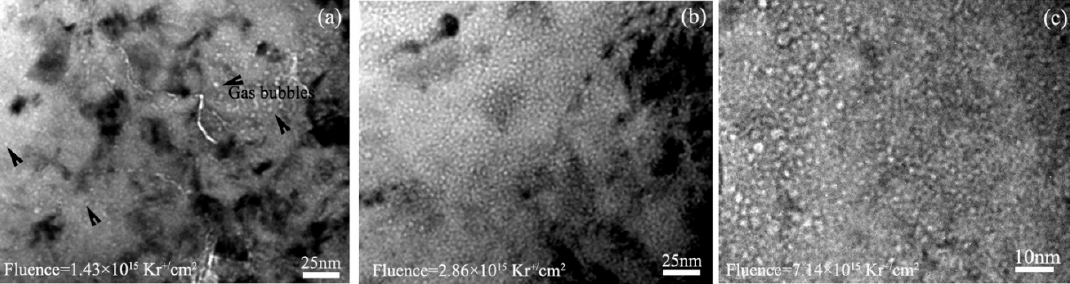
Figure 6 TEM bright field images showing the morphologies of Zr alloy #2 irradiated with ( a ) 1.43 × 10 15 , ( b ) 2.86 × 10 15 , and ( c ) 7.14 × 10 15 Kr + /cm 2 fluence at 360 °C.